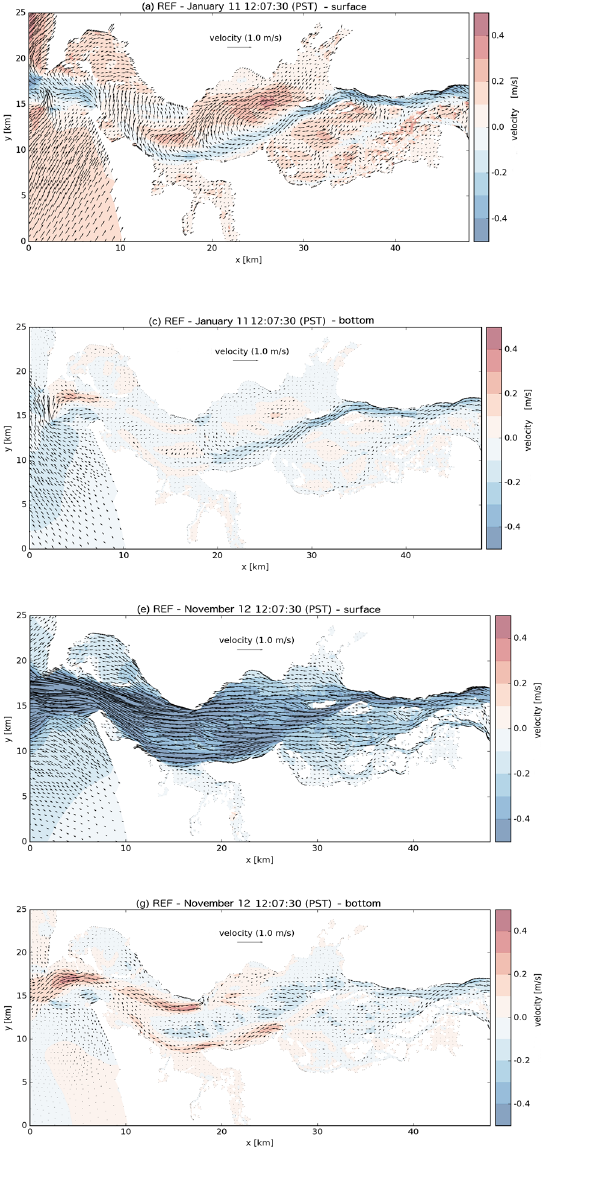
Figure 7. Tidally averaged velocity over the estuary during the events of January and November 2014. ( a ) Surface for REF and ( b ) NOWIND in January. ( c ) Bottom for REF and ( d ) NOWIND in January. ( e ) Surface for REF and ( f ) NOWIND in November. ( g ) Bottom for REF and ( h ) NOWIND in November.